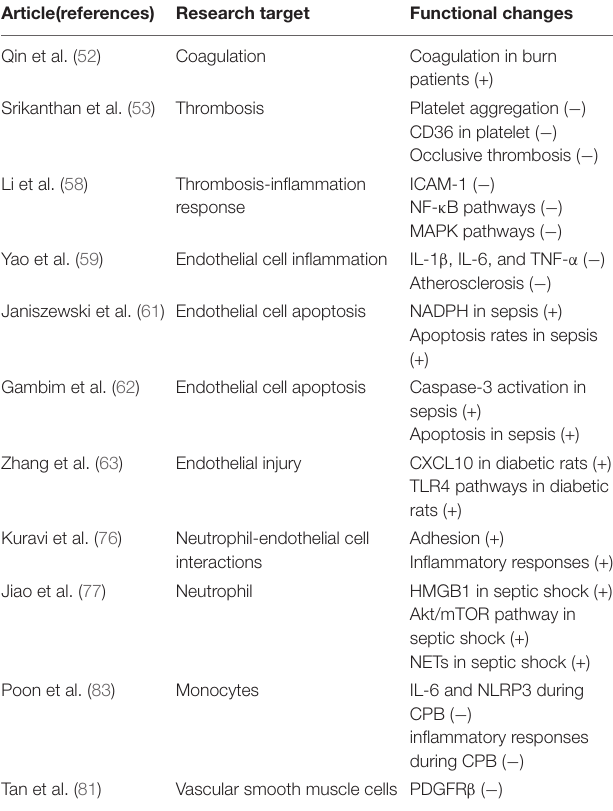
TABLE 1 | The role of PLT-Exo in